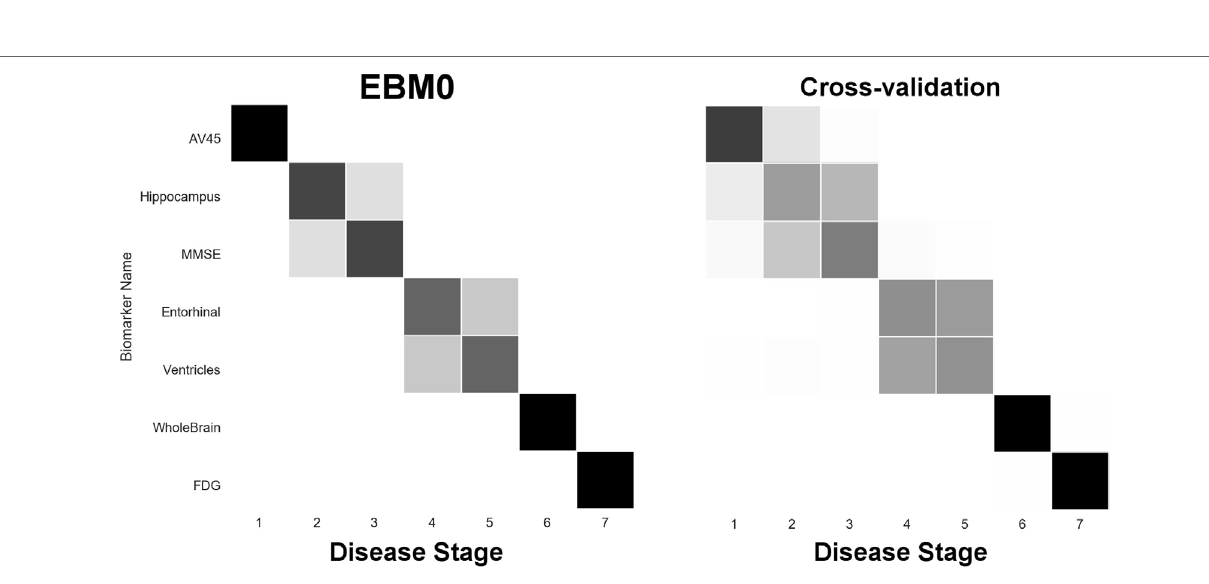
FigUre 5 | EBM for selected standard (non-network) biomarkers, built on data from our anatomical connectome cohort, The168 . Left panel: left-right positional variance of the maximum-likelihood sequence. Right panel: cross-validation of the sequence from bootstrapping.